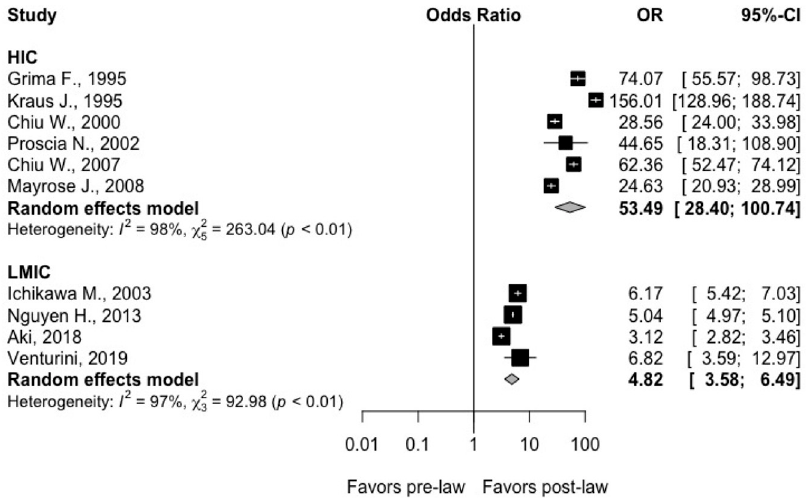
Fig 2. Forest plots demonstrating the OR for increased helmet usage following implementation of helmet legislation (95% CI) in HICs from 6 studies and in LMICs from 4 studies. Solid squares represent the point estimate of each study, and the centers of the clear diamonds represent the estimate of the intervention effect for HIC vs. LMIC. Horizontal lines represent 95% CIs, and the width of the diamonds represents the 95% CI of the pooled ORs. Prediction interval for the OR of helmet usage comparing post- to pre-law enactment in HIC: (5.29; 540.4). In 95% of all meta-analyses, the range of the prediction interval will capture the true effect size of 95% of all new studies in HIC. Prediction interval for the OR of helmet usage comparing post- to pre-law enactment in LMIC: (1.24; 18.7). In 95% of all meta-analyses, the range of the prediction interval will capture the true effect size of 95% of all new studies in LMIC. CI, confidence interval; HIC, high-income country; LMIC, low- and middle-income country; OR, odds